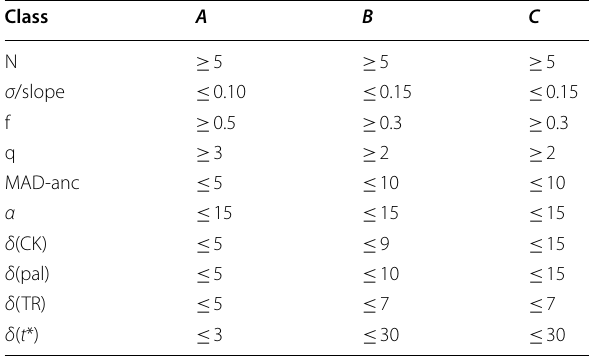
Table 1 Selection criteria and threshold values for the three determination classes (A, B, and C) for Thellier–Coe experiments